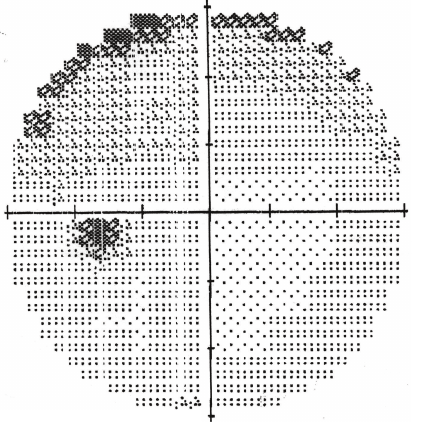
Figure 5: At 10-month postoperative followup, the left eye visual field showed a solitary paracentral scotoma.